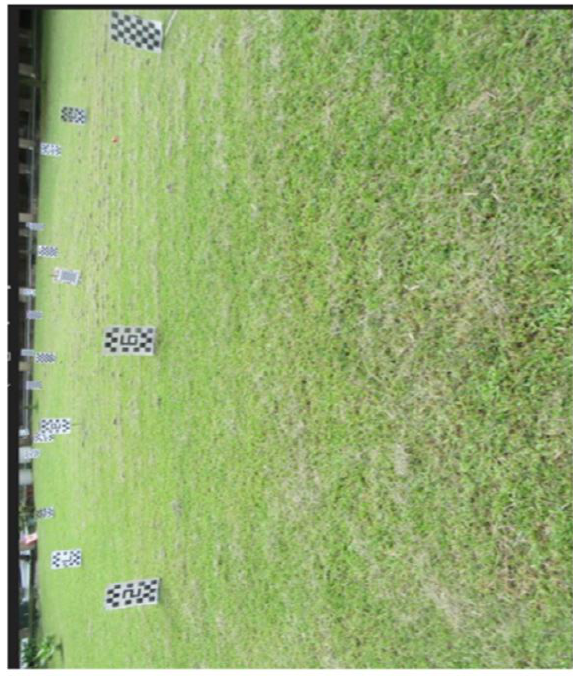
Figure 5: A tilted image occupying targets placed on ground